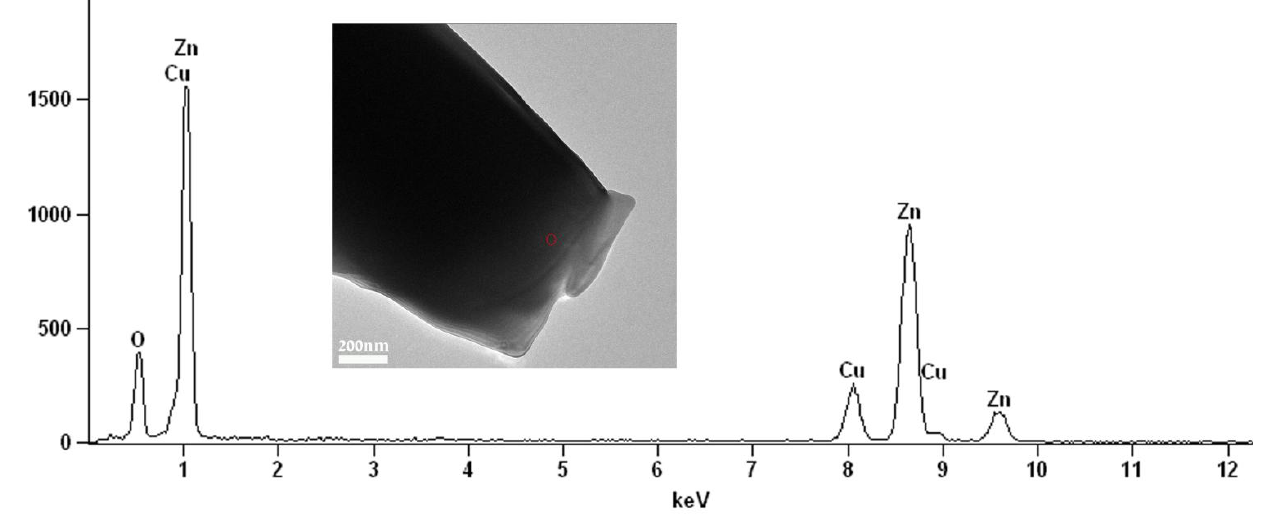
Figure 4. Energy dispersive spectroscopy (EDS) spectrum recorded with a 35 nm electron probe from the “cauliflower-like” ZnO microparticle (marked by the circle on the inset image) showing characteristic peaks of the elements Zn and O. The Cu peak is from the specimen